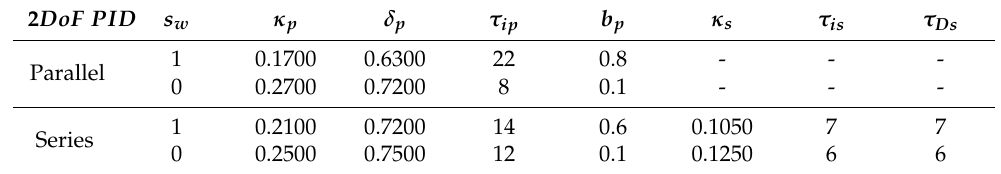
Table 2. Parameters of parallel (pPID) and series PID controllers (sPID) found for (cid:101) yw = (cid:101) yi = 0.001 and (cid:101) uw = (cid:101) ui = 0.3 in PP (41); κ p = K s K cp T 2 and τ Ds = τ ip